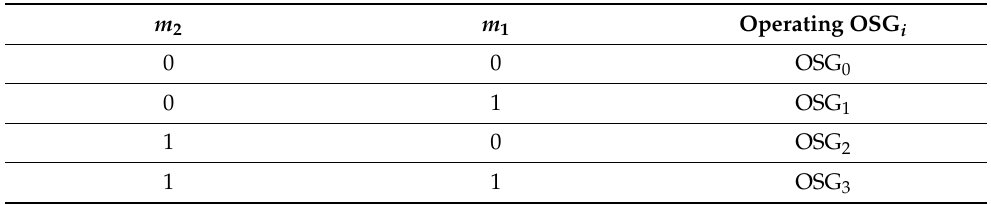
Table 4. The operating condition under m 2 and m 1 .